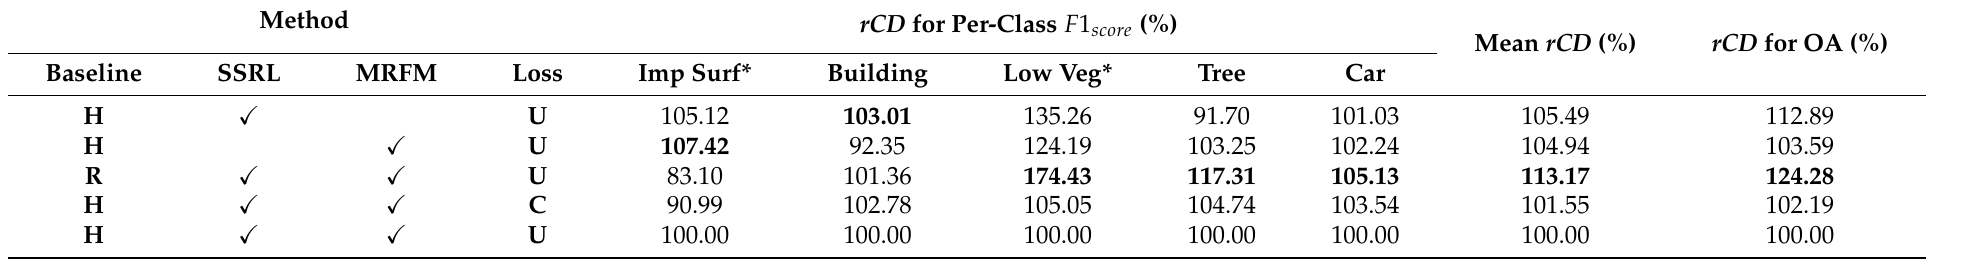
Table 4. The relative CD in ablation study with different components integrated based on clean and fog corrupted variants of the Vaihingen test set. Lower rCD suggests an improvement of robustness in the presence of fog corruption. The highest rCD is bold.